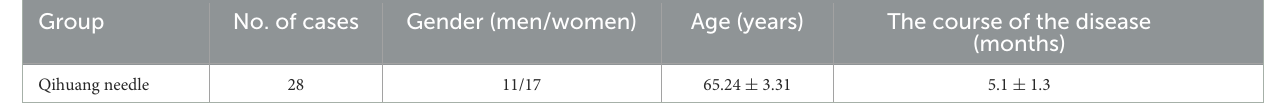
TABLE 1 General